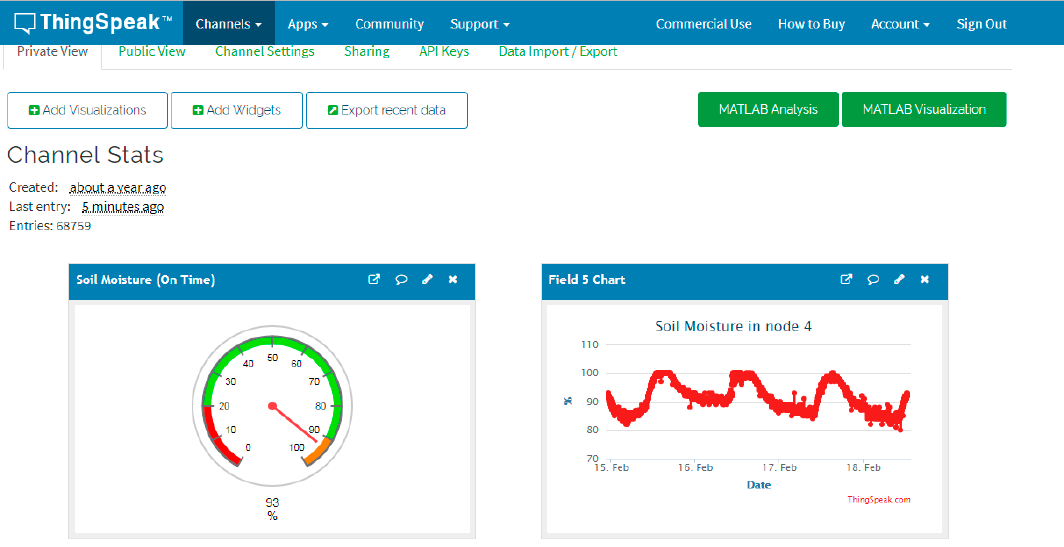
Figure 20. Monitored data at Thingspeak application.